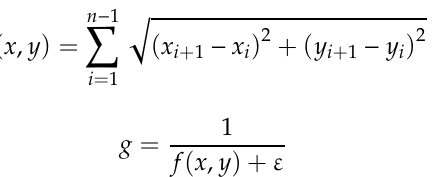
Figure 3. Possible path direction. The optimization problem can be defined as: